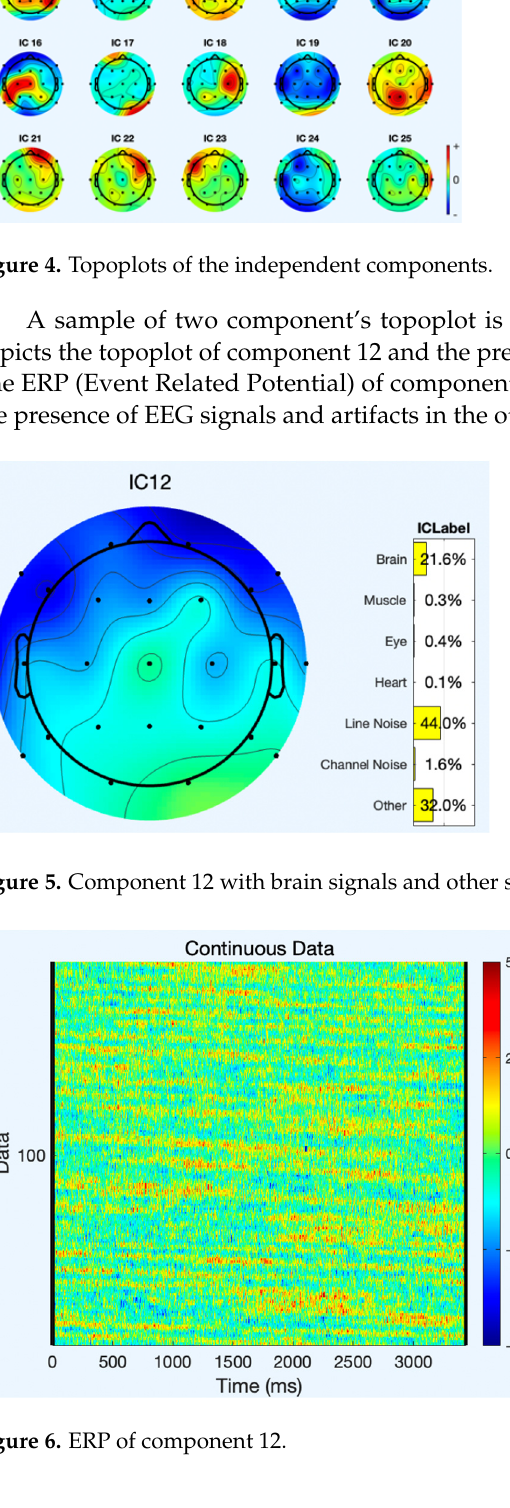
Table 1. EEG and artifacts present in the observed signals.